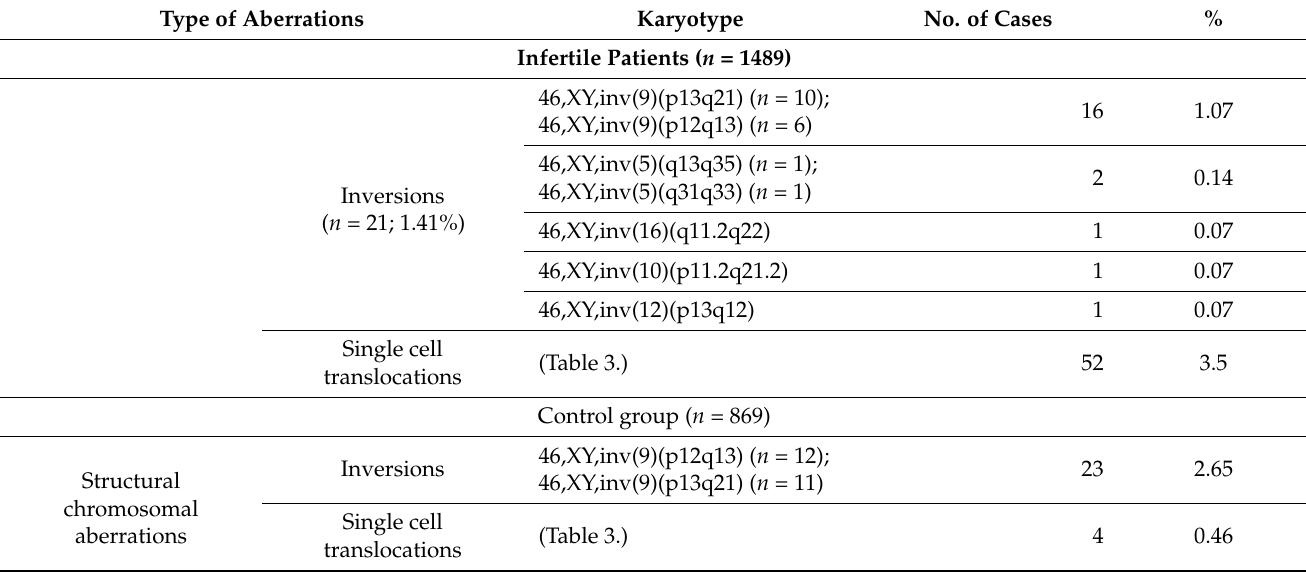
Figure 4. The number of infertile patients and control individuals with inv(9). Figure 5. The number of SCTs in infertile patients and control individuals.